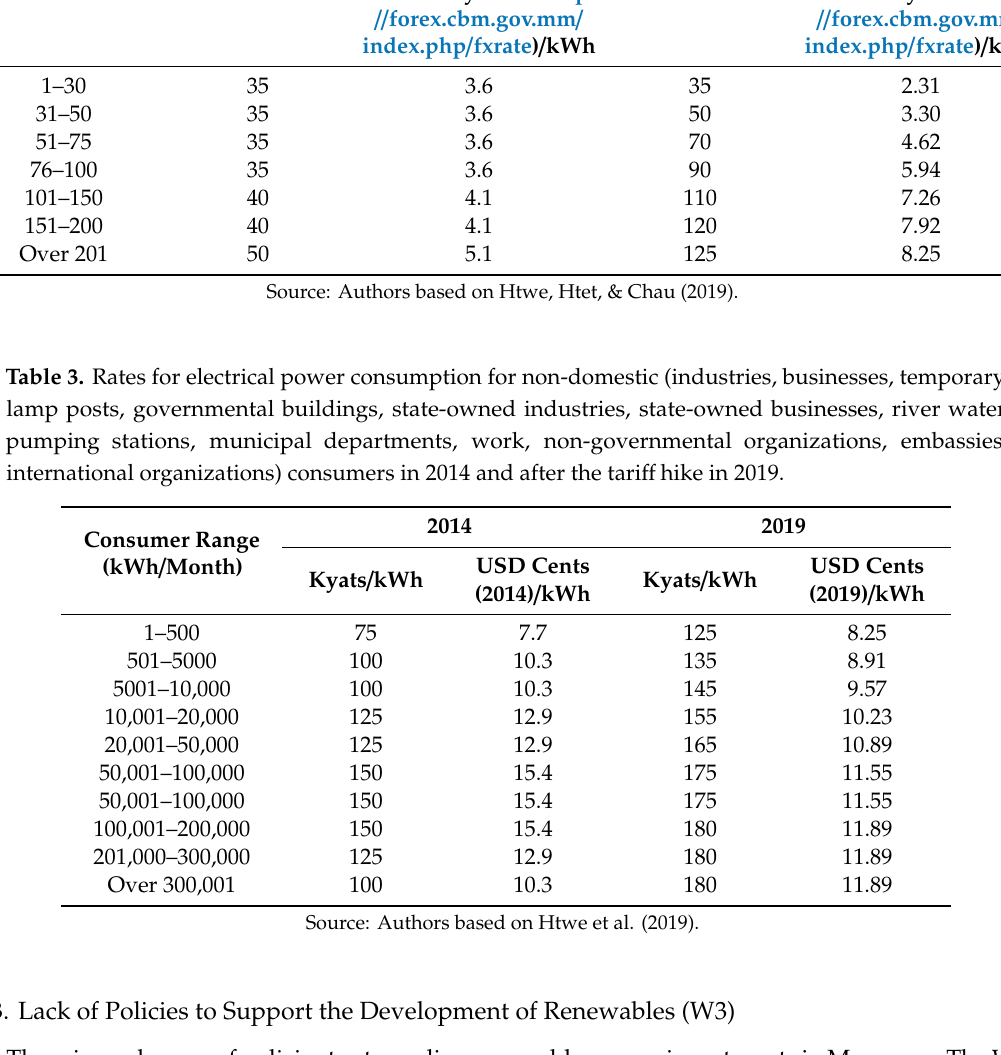
Bank of Myanmar https: // forex.cbm.gov.mm /